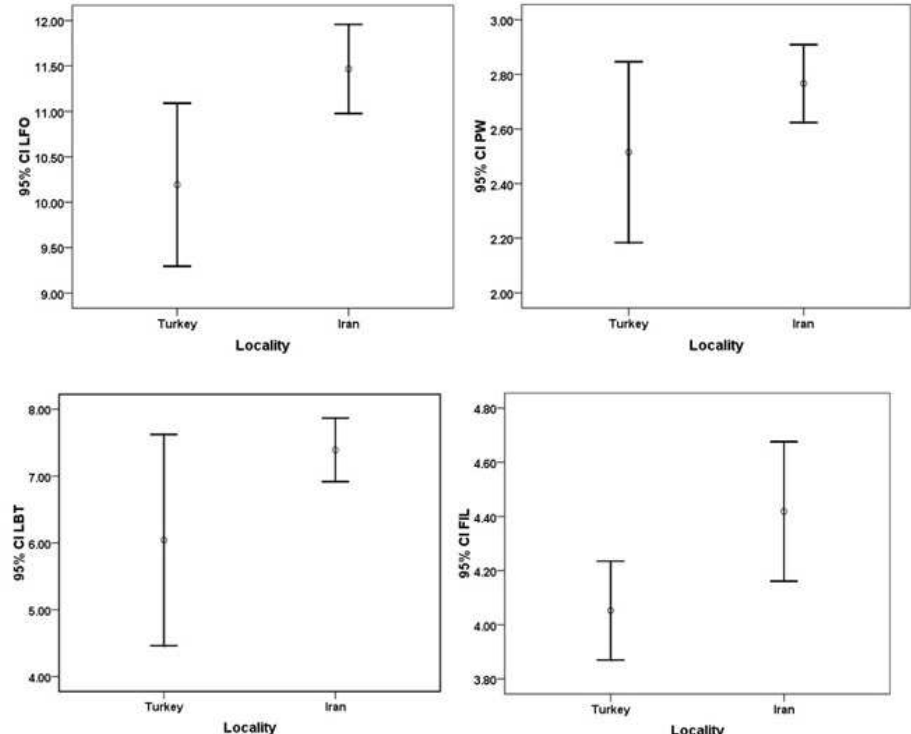
F IGURE 2. Ordination of geographic variation between male individuals of Iran and Turkish populations of Trachylepis vittata for significant ( P ≤ 0.05) morphological